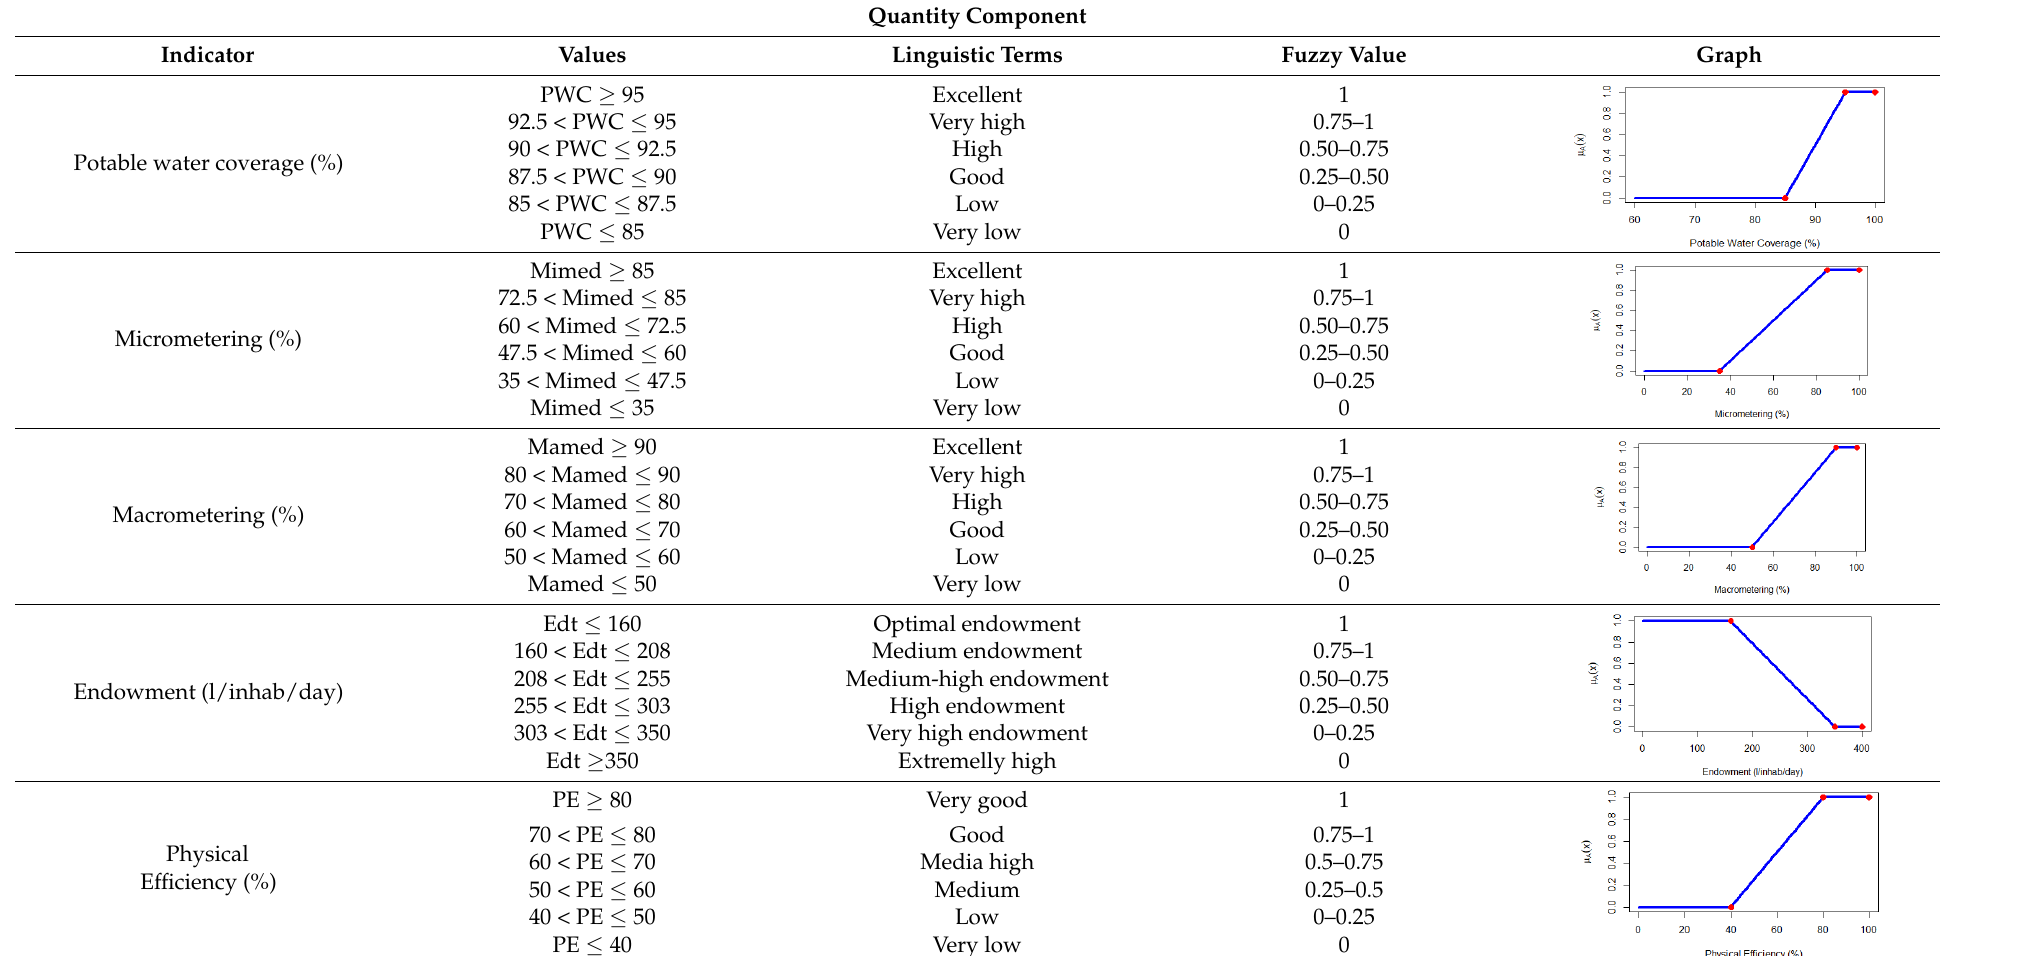
Table 2. Results of the FL method for each component with their respective indicators.